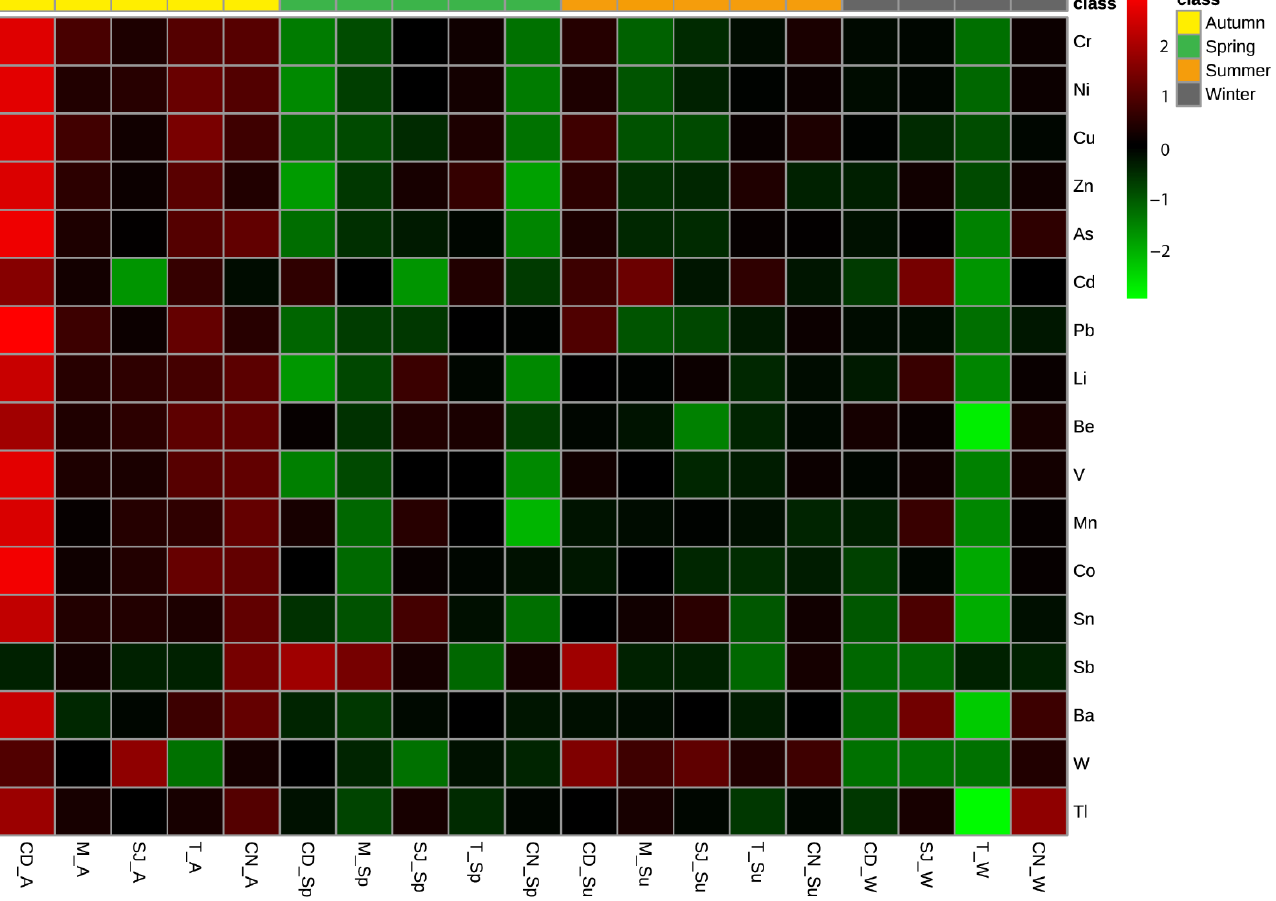
Figure 2. Heatmap comparing trace element concentrations (As, Ba, Be, Cd, Co, Cr, Cu, Li, Mn, Ni, Pb, Sb, Sn, Tl, V, W, and Zn) in sediments from sampling sites. CD, M, SJ, T, and CN represent the sites Cale do Ouro, Murtosa, São Jacinto, Torreira, and Costa Nova, respectively. A, W, Sp, and Su represent the seasons of the year: autumn, winter, spring, and summer.